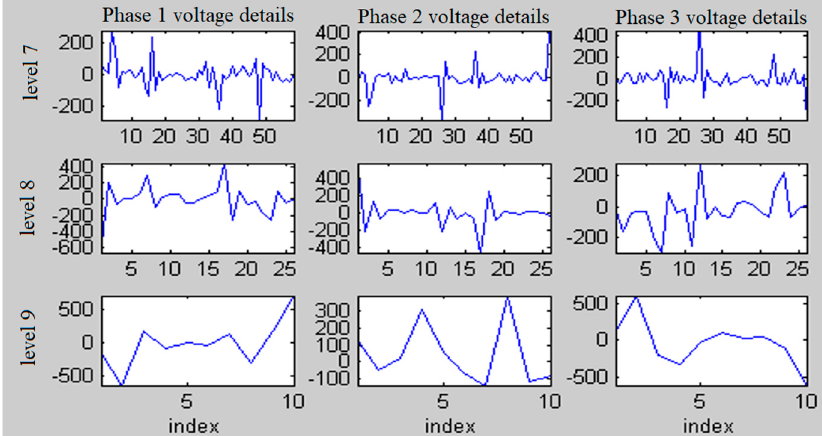
Figure 11. Vectors of details for voltages, levels 7–9, first case study.